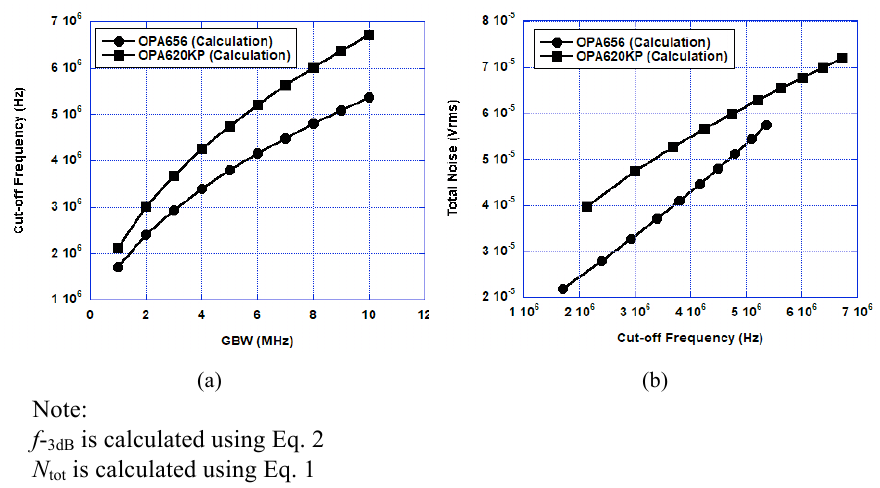
Fig. 3. Comparison results of OPA620KP to OPA656 for different parameter: (a) GBW against f-3dB; (b) f-3dB against